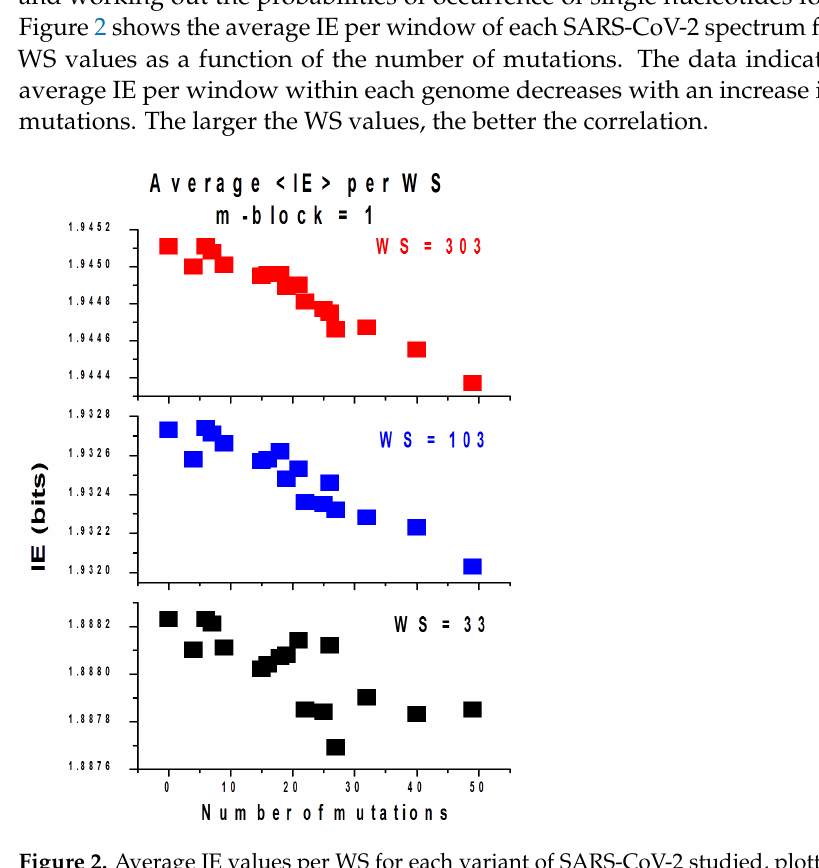
Figure 2. Average IE values per WS for each variant of SARS-CoV-2 studied, plotted as a function of the number of mutations.